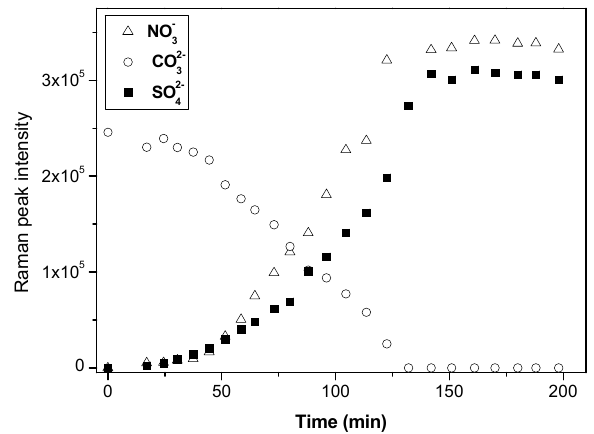
Figure 3. Time series of the Raman peak intensity of NO − , SO 2 − , 3 4 and CO 2 − during the reaction of SO 2 with O 2 / NO 2 / H 2 O on 3 CaCO 3 particles. SO 2 : 75ppm, NO 2 : 75ppm, RH: 72%, O 2 : 20%. The intensity of NO − , SO 2 − , and CO 2 − show the peak area at 3 4 3 1050, 1010, and 1087cm − 1 , respectively, in Raman spectra ob- tained by Raman